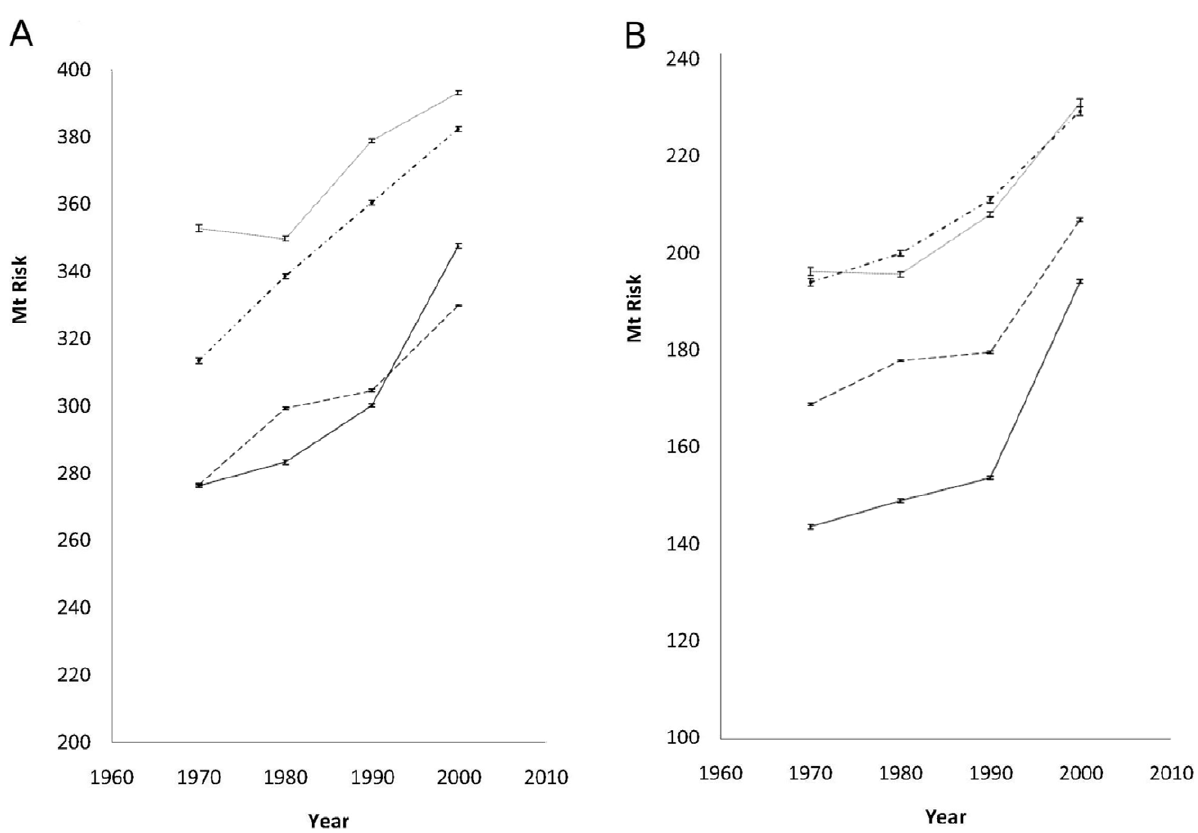
Figure 4. Past trends in fasciolosis risk. Change in F. hepatica risk for England (dashed line), Scotland (solid line), Wales (dashed and dotted line) and Northern Ireland (dotted line), 1970–2006 ( 6 SE) for a) summer and b) winter.